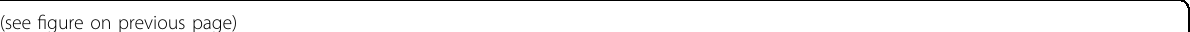
Fig. 5 Overexpressed NR5A2 transcriptionally increased the expression of GDF15 in pancreatic cancer. A , B PANC-1 cells infected by siControl or siNR5A2 were harvested for Transcriptome RNA sequencing. Boxplot ( A ) and Principle Component Analysis ( B ) to show the quality control of RNA sequencing. C , D Volcano map ( C ) and heat map ( D ) to show that GDF15 was signi fi cantly downregulated in NR5A2 silenced PANC-1 cells. E Gocircle plot to show that several cancer-related GO terms were downregulated in NR5A2-silenced PANC-1 cells. F GO Chord plot indicated that GDF15 was a component of multiple downregulated tumor-promoting gene sets. G , H . AsPC-1 and HPAC cells infected with shControl or shNR5A2 were harvested for Western blots ( G ) and RT-qPCR analysis ( H ). GAPDH served as an internal reference. All the data are mean ± S.D. from experiments with three replicates. *** p < 0.001. Statistical analyses were performed using an unpaired t test. I , J . AsPC-1 and HPAC cells infected with pcDNA3.1 or NR5A2 plasmid were harvested for Western blots ( I ) and RT-qPCR analysis ( J ). GAPDH served as an internal reference. All the data are mean ± S.D. from experiments with three replicates. *** p < 0.001, unpaired t test. K – M IHC Images ( K ) of NR5A2 and GDF15 staining using TMA tissue sections ( n = 31). The scale bars were shown as indicated. Heatmap ( L ) and dot plot ( M ) to show the correlation of IHC scores for the expression of the NR5A2 and GDF15 proteins in pancreatic cancer patient specimens. ( r = 0.66 for spearman correlation coef fi cients, p = 4.7e − 05). N The GDF15 promoter sequences and putative NR5A2 binding sites were obtained from the Eukaryotic Promoter Database (EPD) (https://epd.ep fl .ch//index.php). O ChIP- qPCR of NR5A2 in AsPC-1 and HPAC cells. All data are shown as the mean values ± SD from three replicates. ns not signi fi cant; *** p < 0.001, unpaired t